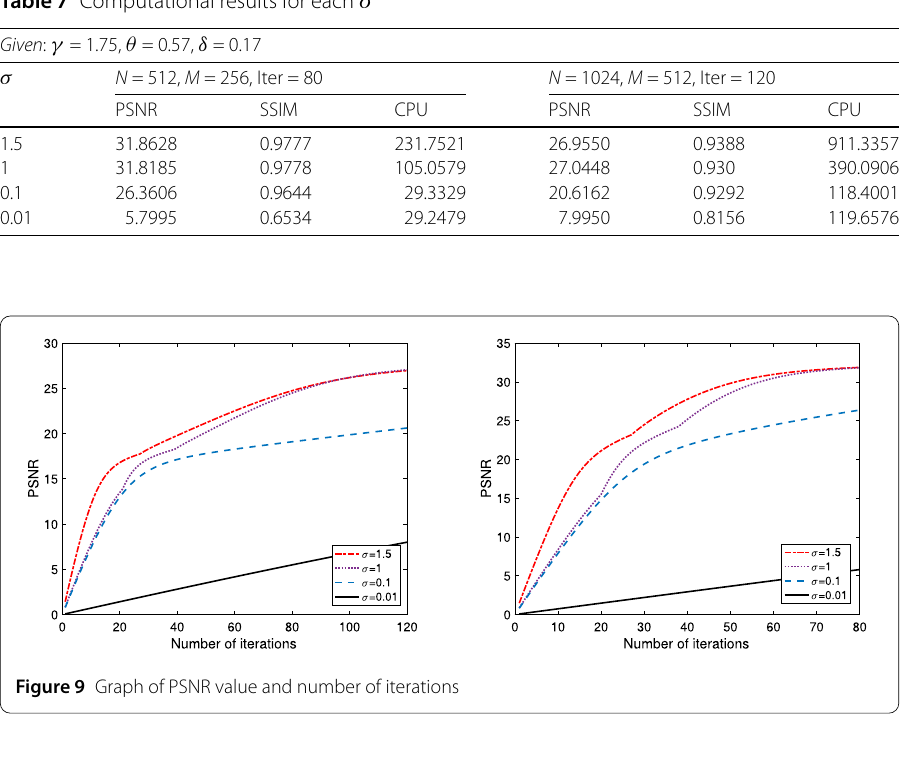
Table 8 Computational results for each γ Given : σ = 5, θ = 0.57, δ =